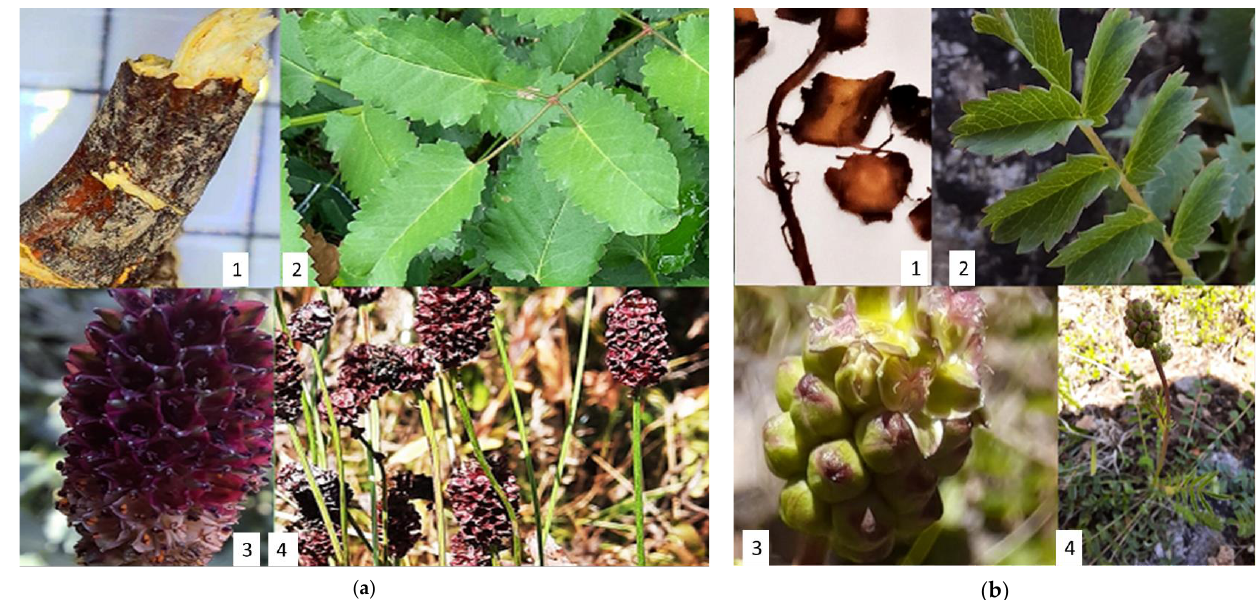
Figure 1. ( a ). S. officinalis L. from Bihor county, RO, where 1-Root, 2-Leaves, 3-Flower, 4-Stems and flowers. ( b ). S. minor Scop. from Cluj county, RO where 1-Root, 2-Leaves, 3-Flower, 4-Stems, flowers, leaves (personal photos).